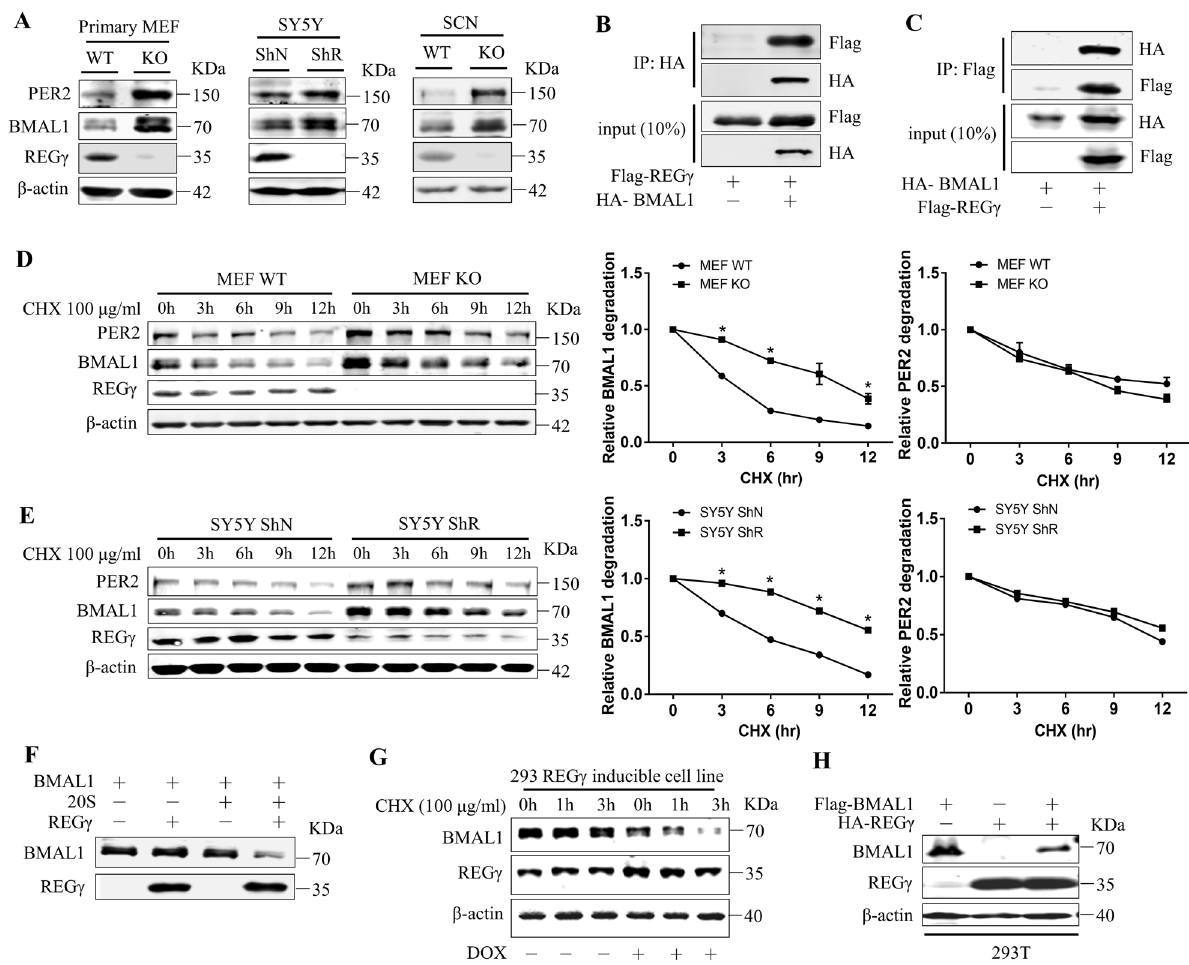
Fig. 4 REG γ directly interacts with BMAL1 and promotes its degradation. A Expression of REG γ , BMAL1, and PER2 in MEF WT/KO, SY5Y ShN/ ShR cells, and REG γ WT/KO mouse SCN. B Interaction between REG γ and BMAL1, determined by co-immunoprecipitation and western blot analysis following transient transfection of 2 μ g of HA-BMAL1 and 2 μ g of Flag-REG γ into 293T cells. C Reciprocal interaction between REG γ and BMAL1 was analyzed by transient transfection of 2 μ g of Flag-REG γ and 2 μ g of HA-BMAL1 into 293T cells. D , E Stability of endogenous BMAL1 in MEFs and in SY5Y cells was analyzed in the presence of CHX (100 μ g/ml) for the indicated time points followed by western blot analysis. F In vitro proteolytic analysis of REG γ -mediated degradation of BMAL1. Puri fi ed REG γ , 20S proteasome, and in vitro-translated BMAL1 were incubated at 30 °C for 3 h as indicated. G Expression of REG γ was induced by doxycycline (1 μ g/ml DOX for 48 h) in an engineered 293 cell line followed by western blot analysis of BMAL1 stability in the presence of cycloheximide as indicated. H 293T cells were transfected with Flag-BMAL1 and HA-REG γ followed by western blot analysis for REG γ and BMAL1 correlation. The quantitative results of BMAL1 stability in D , E were plotted to indicate dynamic changes. Values represent mean ± SD. * p < 0.05; t test, WT vs. KO; ShN vs.